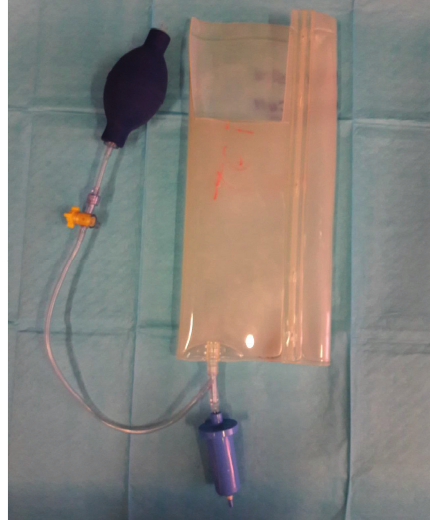
Figure 2: A plastic transfusion pressure infusor. Note the missing rubber part used to construct the hood.